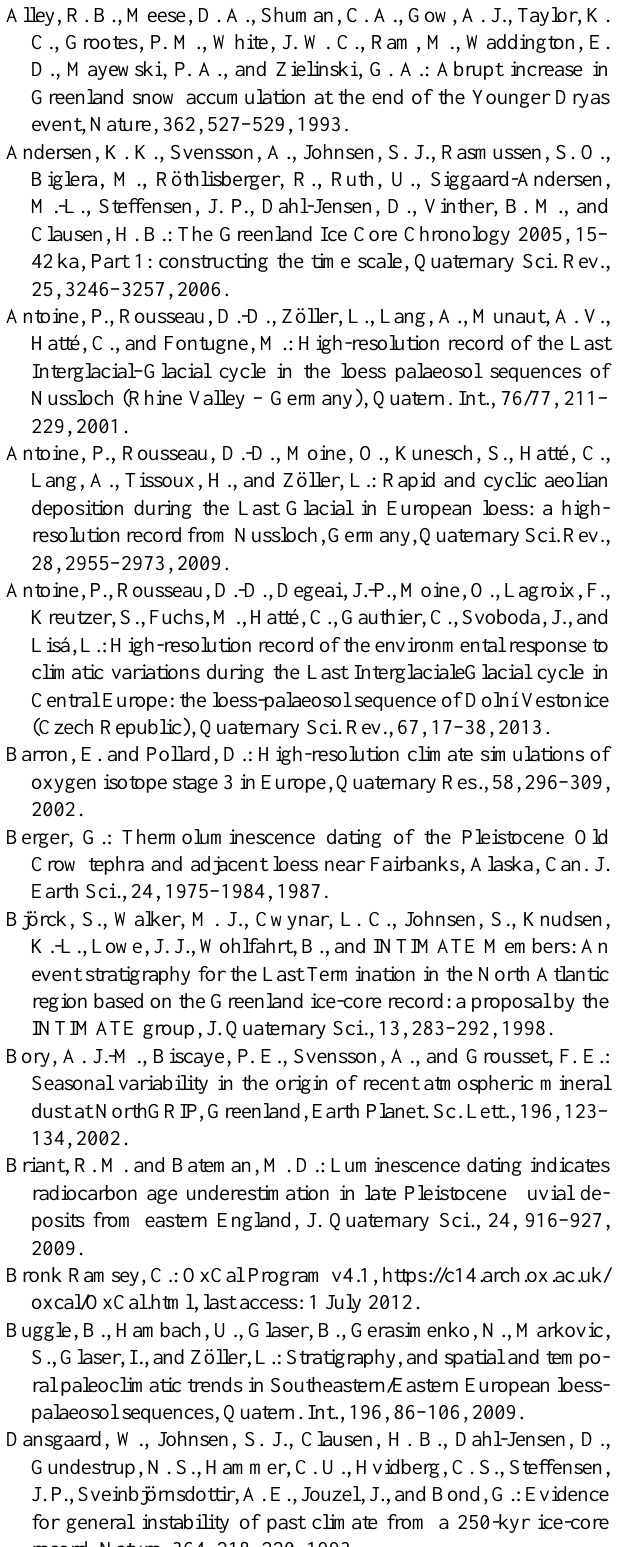
Fig. 2. Anatoly Molodkov kindly provided information on the Arapovichi loess section in Ukraine. We thank Scott D. Wilson for correcting the English. Edited by: T.